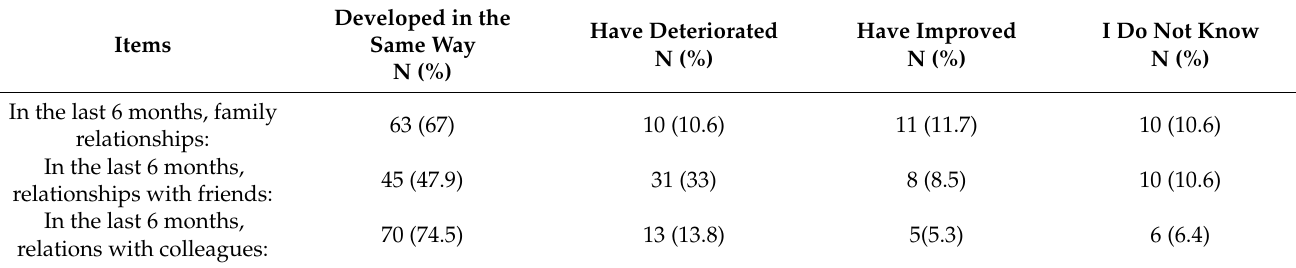
Table 6. Relationship with family members, friends, and colleagues—in the last 6 months 1 .